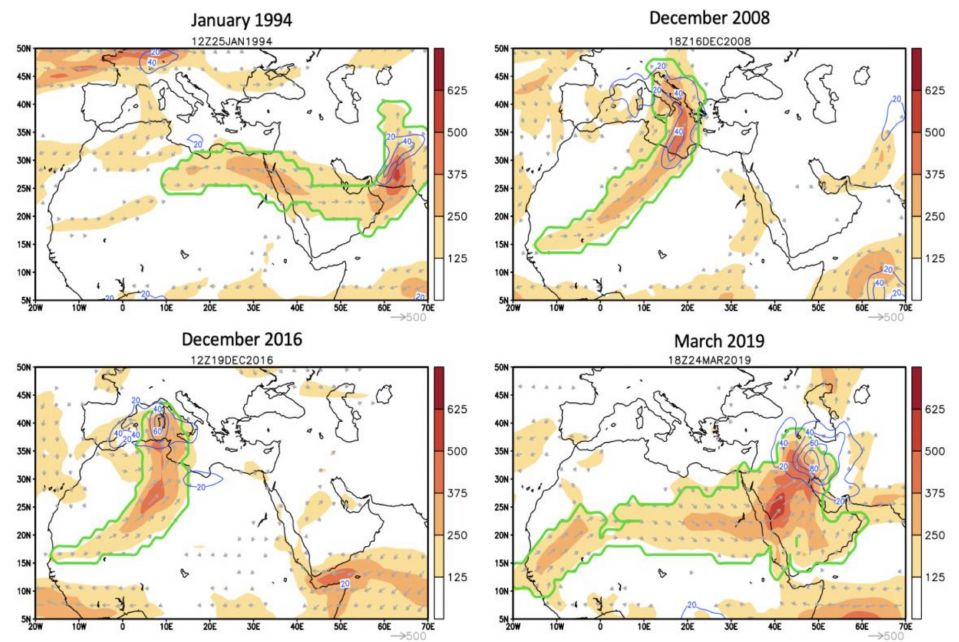
Figure 2. Individual AR cases: ( Top left ) AR event in January 1994. ( Top Right ) AR event in December 2008. ( Bottom Left ) AR event in December 2016. ( Bottom Right ) AR event Dena in March 2019. (Legend) Green: AR shape from the AR detection algorithm. Arrows: integrated water vapor transport (IVT) vectors (not shown if magnitude smaller than 100 kg / m / s). Shading: IVT magnitude (kg / m / s). Blue: 2-day cumulative precipitation (in mm) centered on the time step shown in the panel title.